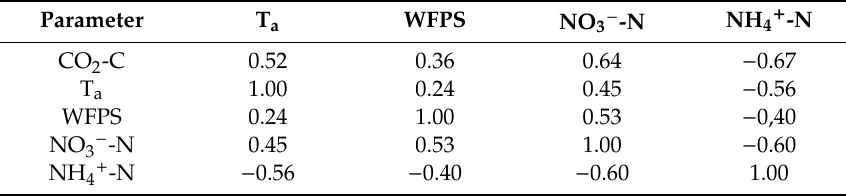
Table 2. Correlation coe ffi cients (at p < 0.05) between CO 2 -C emission from arable soils and